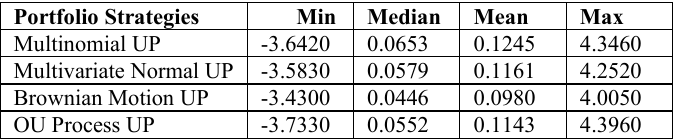
Table 2. Middle term duration data analysis (4 years